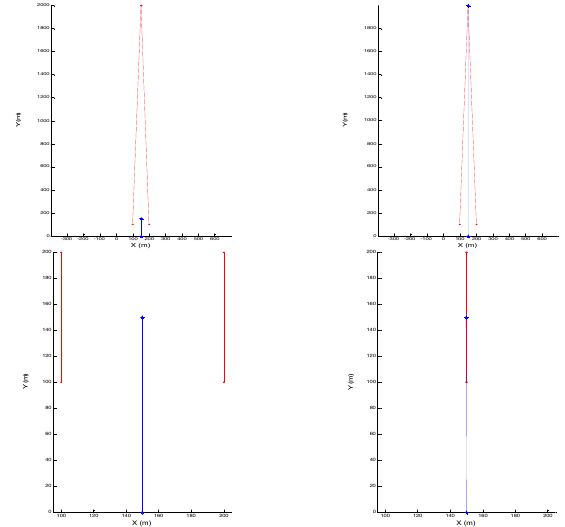
Figure 4. Subject vertex (blue) shifted ‘out-of-bounds’ (~2,000 meters) due to use of ill-specified correspondences (top); and, collapsing parallel line (red) segments (bottom) Statistical measures are incorporated in the process, which identify ambiguous correspondences existing between